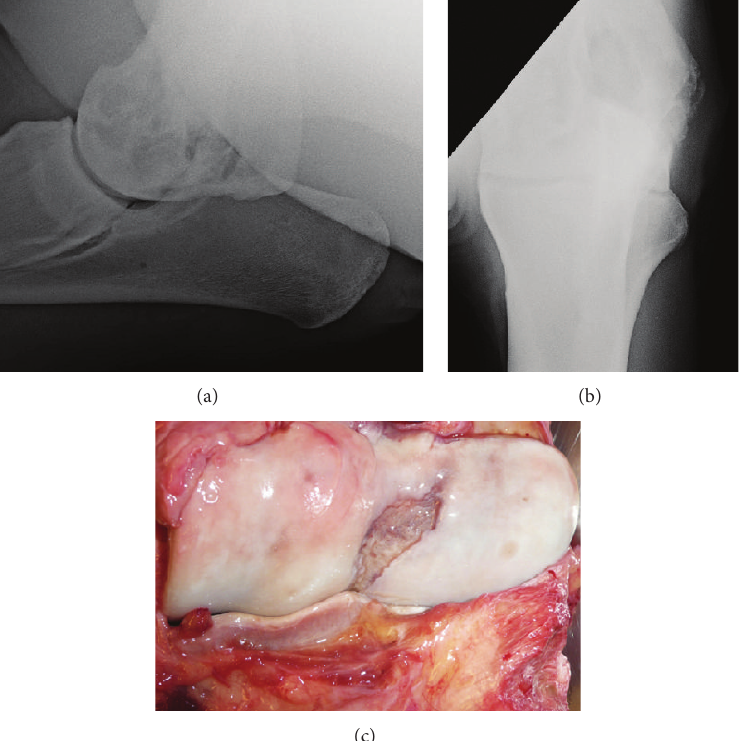
Figure 3: Radiographs of the right elbow at second presentation in (a) lateromedial and (b) craniocaudal view. Severe osteolysis of the right humeral condyle and marked irregularity and osteolysis of the lateral epicondyle of the right humerus are noted. (c) Photographic image of the right humeral condyle from the cranial aspect of the right humerus. A large defect secondary to osseous metastasis is noted in the centrolateral aspect of the condyle of the right humerus.